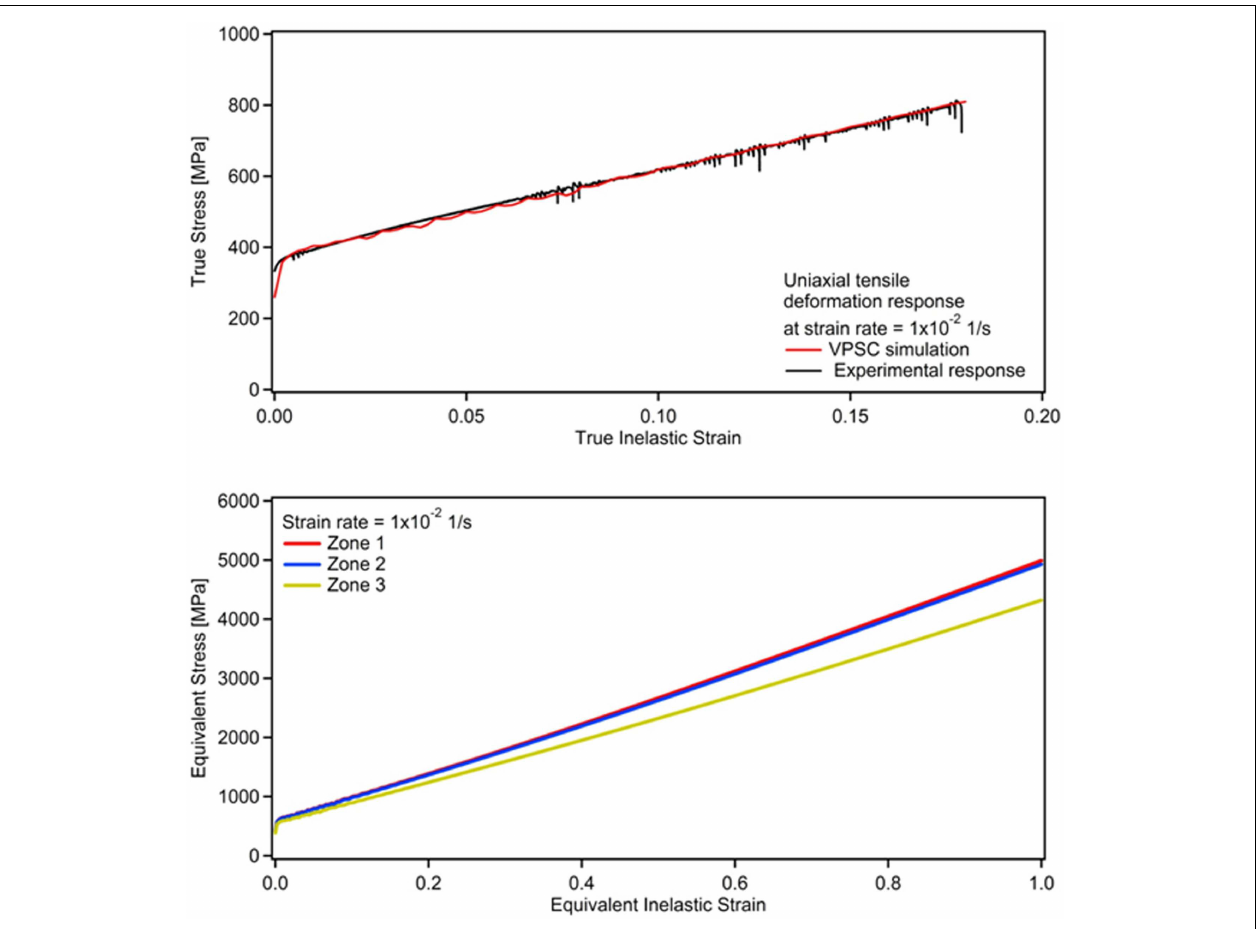
FIGURE 6 |Top:VPSC simulation of the RT experimental uniaxial tensile deformation of Hadfield steel at a strain rate of 1 × 10 − 2 1/s . Bottom: the corresponding predicted equivalent stress–strain response for each zone within the impact sample based on the distribution of stress concentration ( Figure 4